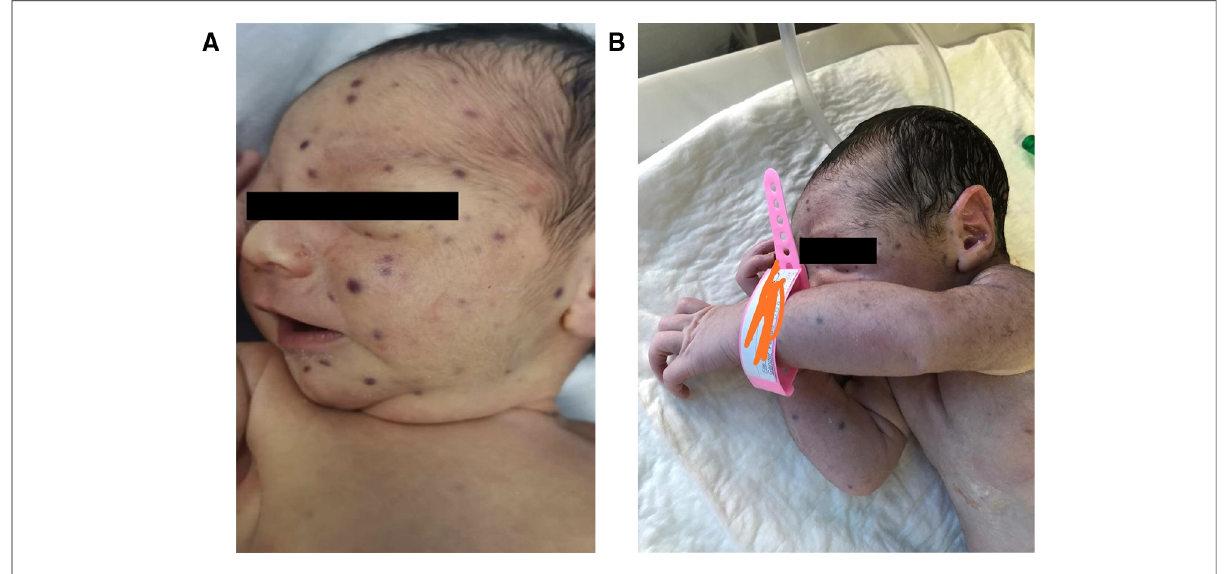
FIGURE 1 Blueberry muf fi n baby. ( A ) & ( B ) Disseminated dark red to purplish macules and papules on the face, neck, and upper